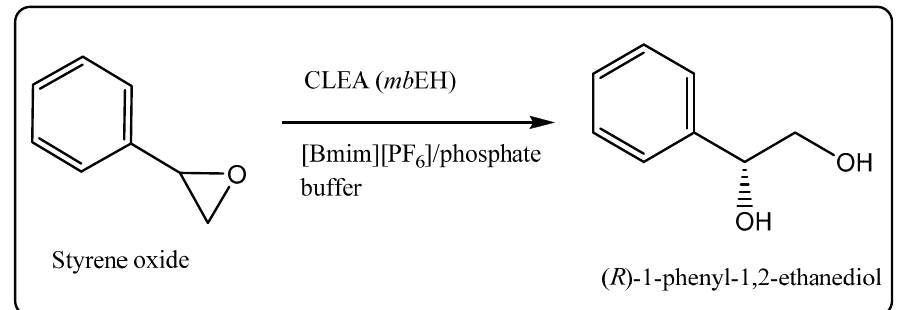
Figure 2. Enzyme encapsulation in an ionic liquid-based polymer